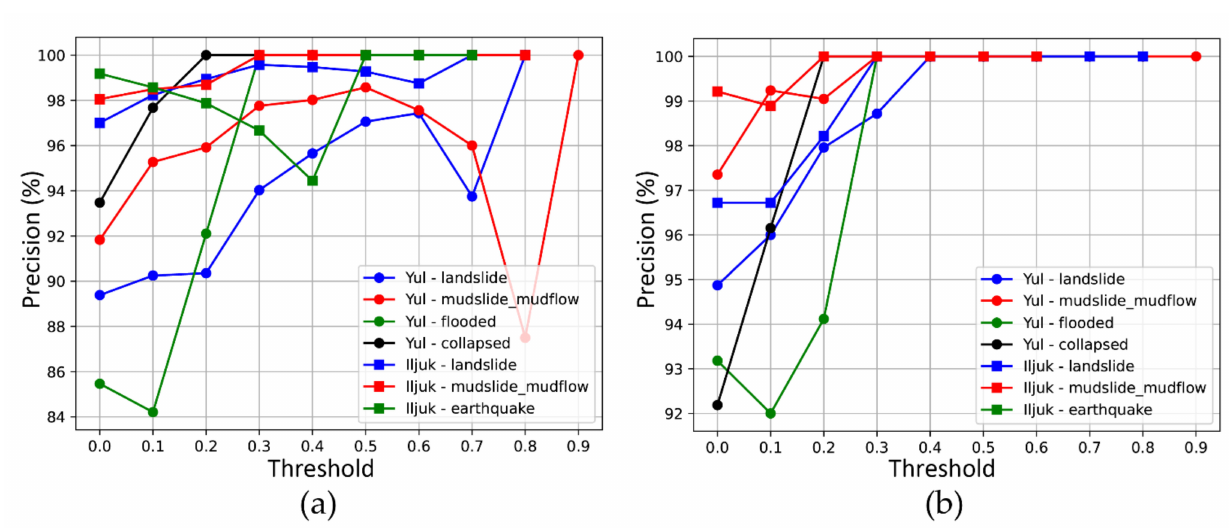
Figure 7. Evaluation of principal image classification using 5 August dataset: ( a ) result without hotspot analysis and ( b ) result with hotspot